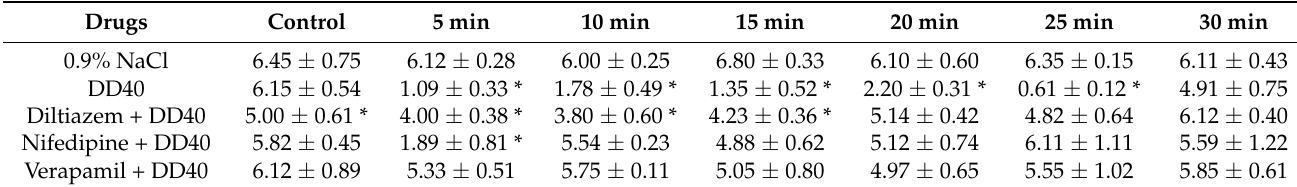
Table 5. Frequency of ruminal contraction of the five groups (control, DD40, diltiazem + DD40, nifedipine + DD40, verapamil + DD40) during the experiments [34].